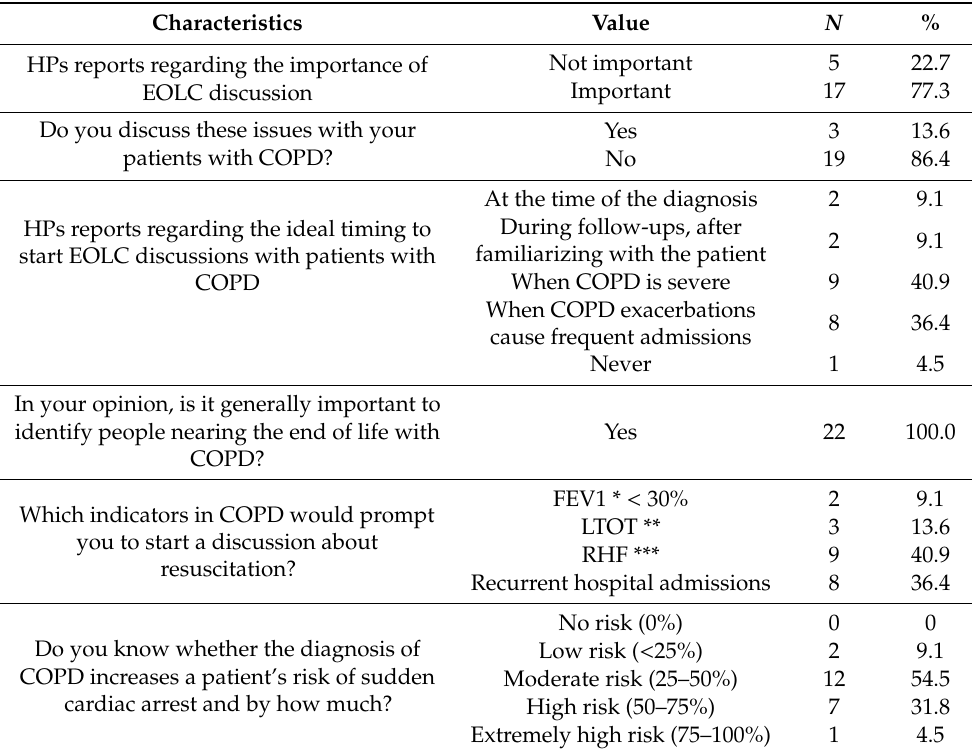
Table 3. EOLC data regarding HPs ( N =